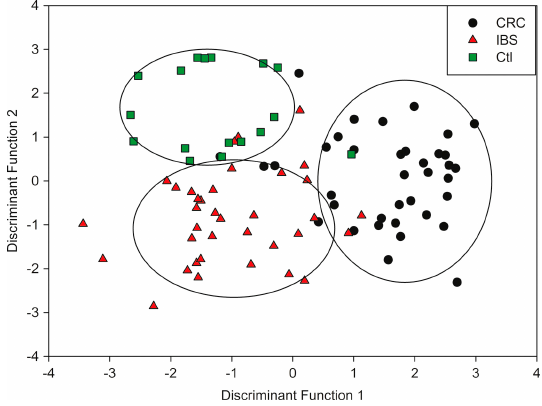
Figure 7. LDA classification separating all three sample groups of CRC, Irritable Bowel Syndrome (IBS) and healthy controls (Ctl). Used with permission from [45].